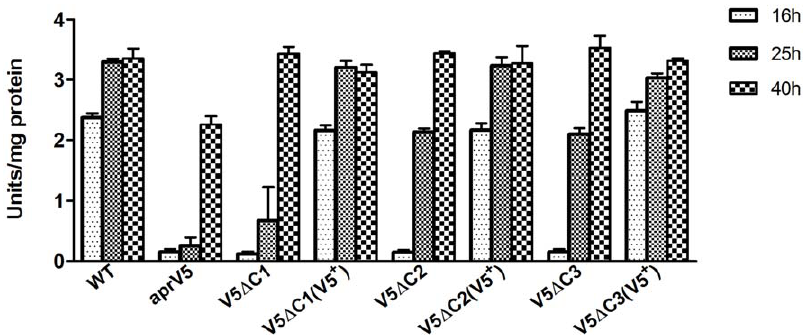
Figure 3. Quantitative analysis of protease activity of deletion mutants. Total protease activity in culture supernatants was determined with azocasein as the substrate. The culture supernatants from 16 h, 25 h and 40 h TAS broth cultures of the wild type strain VCS1703A (WT), the aprV5 mutant JIR3756 ( aprV5 ), the aprV5 D 478–595 strain JIR3947 ( V5 D C1 ), the aprV5 D 503–595 strain JIR3956 ( V5 D C2 ), the aprV5 D 560–595 strain JIR3969 ( V5 D C3 ) were analysed as well as their complemented derivatives: JIR3968 ( V5 D C1 ( V5 + )), JIR3965 ( V5 D C2 ( V5 + )) and JIR3978 ( V5 D C3 ( V5 + )). All values were obtained from three independent biological samples. Error bars represent SEM.